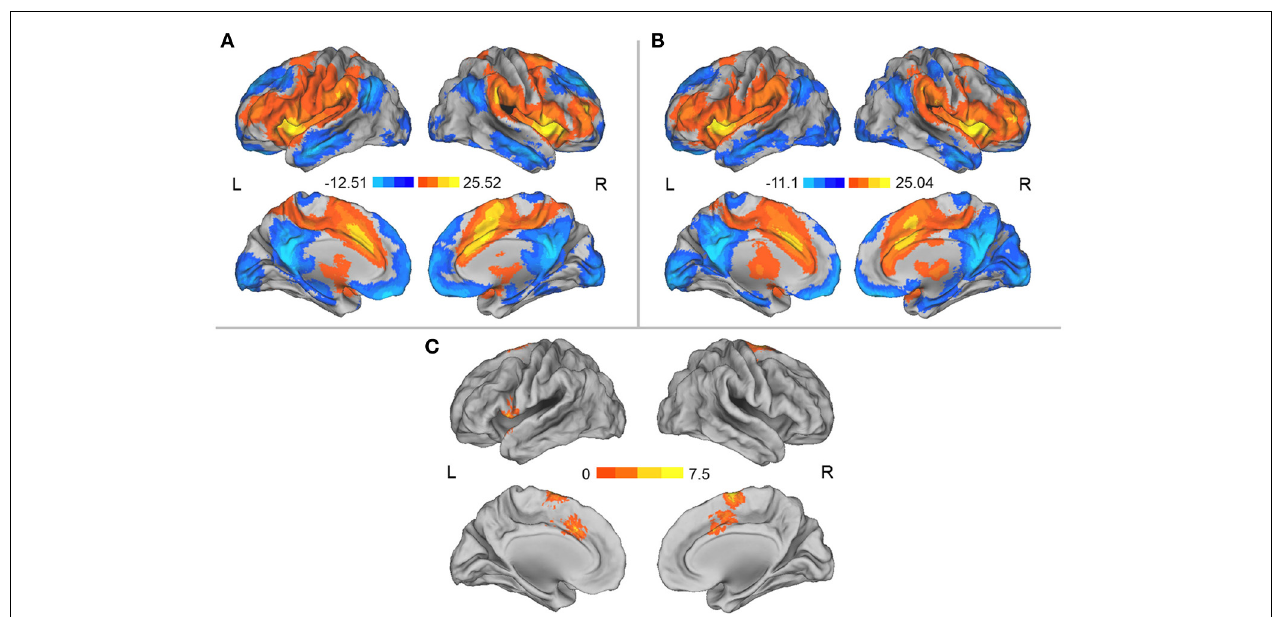
FIGURE 2 | (A) Regions showing significant RSFCs with the left aINS before HDT bed rest. (B) Regions showing significant RSFCs with the left aINS after HDT bed rest. (C) Regions showing significant changes in positive RSFCs